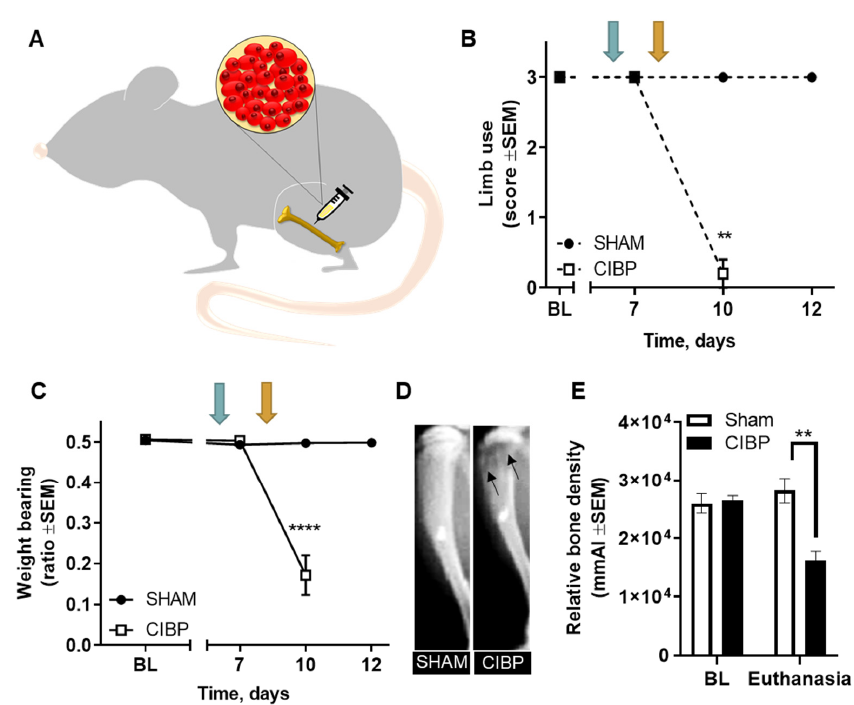
Figure 1. The Walker 256 rat model of cancer-induced bone pain (CIBP). ( A ) A rat model of CIBP was set up through intratibial inoculation of 10 5 Walker 256 breast carcinoma cells in female Sprague Dawley rats. ( B , C ) Cancer-bearing rats presented significantly lower limb-use scores ( B ) and weight-bearing ratios ( C ) at post-surgical day 10, compared with sham. ( D ) Representative X-ray images displaying a sham tibia (left) and a cancer-bearing tibia (right) and endpoint. Arrows indicate areas of bone degradation. ( E ) Intratibial cancer cell inoculation led to a significantly lower relative bone density in cancer-bearing tibias compared with baseline; no changes in relative bone density were observed in sham tibias. ( B , C ). Blue arrows indicate the time point just before the development of pain-like behaviors (post-surgical day 6) and orange arrows illustrate the early stage of CIBP, where the pain-like behaviors initiate (post-surgical day 8). Sham n = 5; CIBP n = 5. BL = baseline. Data are presented as mean ± standard error of the mean (SEM). ** p < 0.01; **** p < 0.0001.